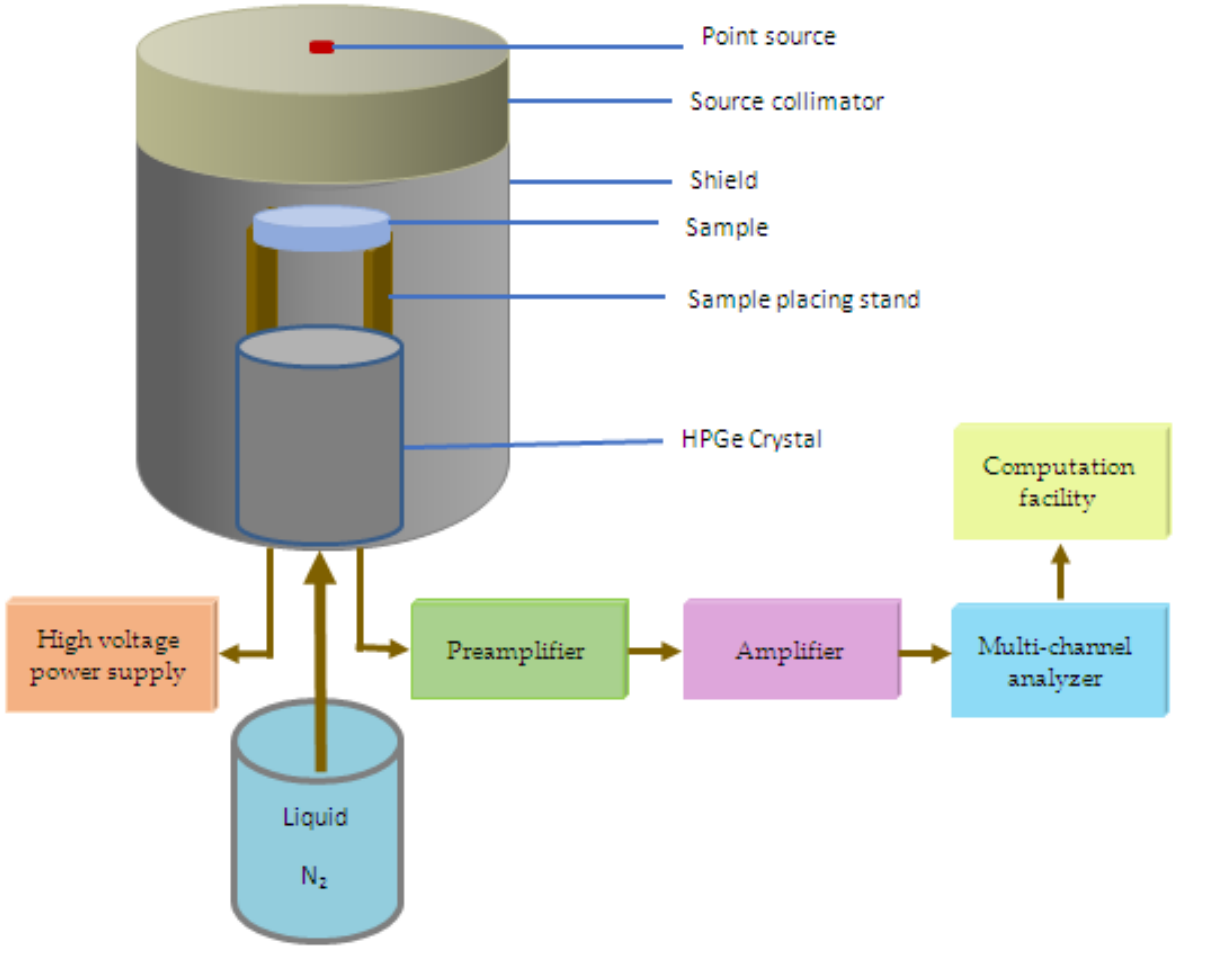
Figure 2. The arrangement of the experimental work.